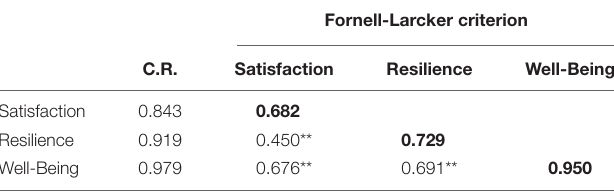
TABLE 4 | Composite reliability and discriminant validity of the